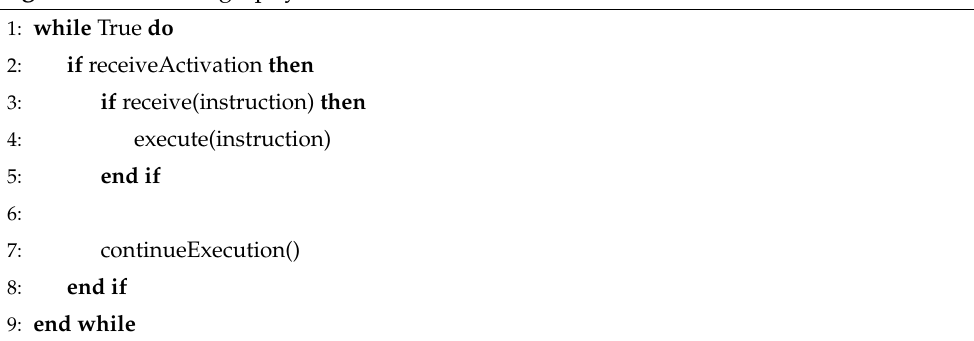
Algorithm 2 Choreography member execution.